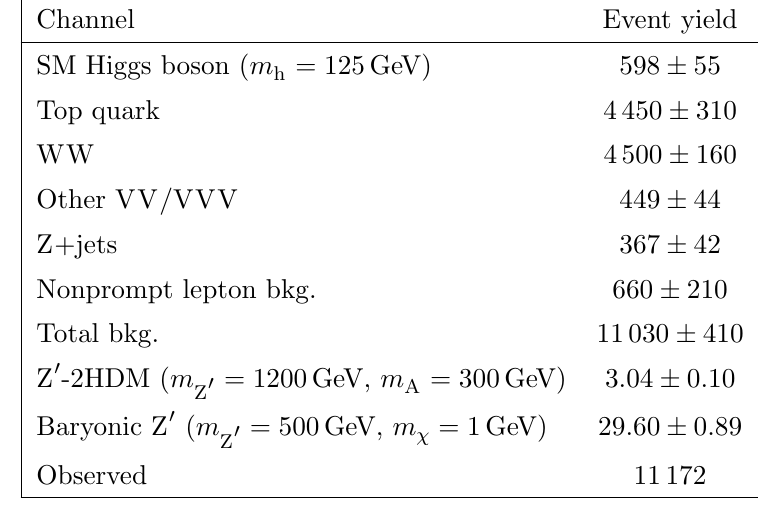
Table 6 . The post-(cid:12)t signal and background event yields, and the observed number of events in data, for the h WW analysis. The expected numbers of signal events for the two signal ! hypotheses are also reported, one for each benchmark model. The total uncertainty, including both statistical and systematic components, is quoted for the expected signal and backgrounds